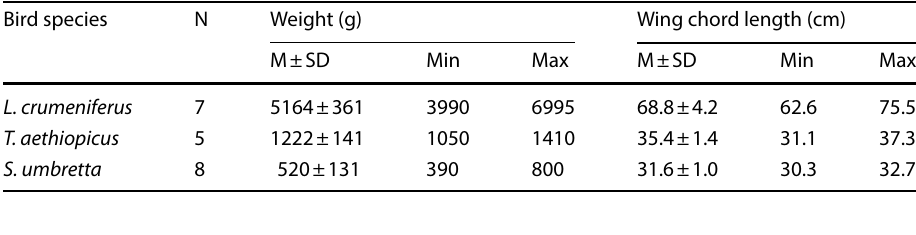
Table 2 Total length and weight of fish species sampled from Lake